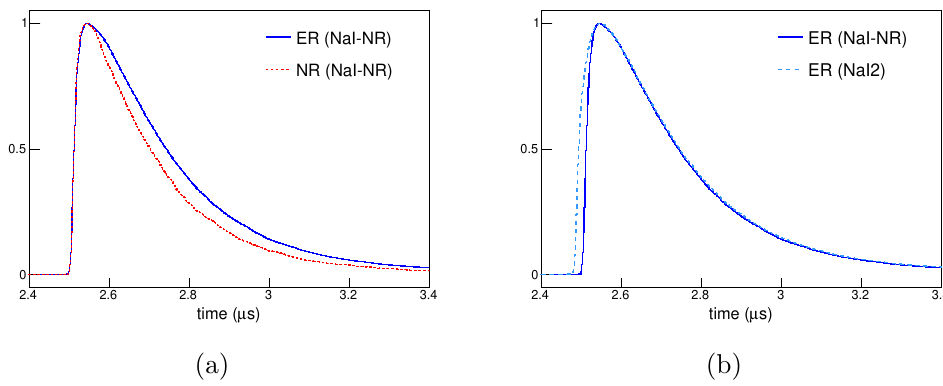
Figure 2 . The averaged waveforms for NaI-NR and NaI2 signals in the 2 to 10 keV energy region. (a) The solid blue curve and dotted red curve represent averaged ER- and NR-induced waveforms in NaI-NR, respectively, where distinctly di(cid:11)erent decay times are evident. (b) The averaged waveform of the ER-induced events in NaI2 (dashed sky-blue line) is compared with that in NaI-NR. The waveform from NaI2 is slightly adjusted to get same maximum point with that from NaI-NR (solid blue line). The averaged ER-induced waveform in NaI2 shows clearly slower rise-time than that in NaI-NR, but the similar decay-time as that seen in the smaller